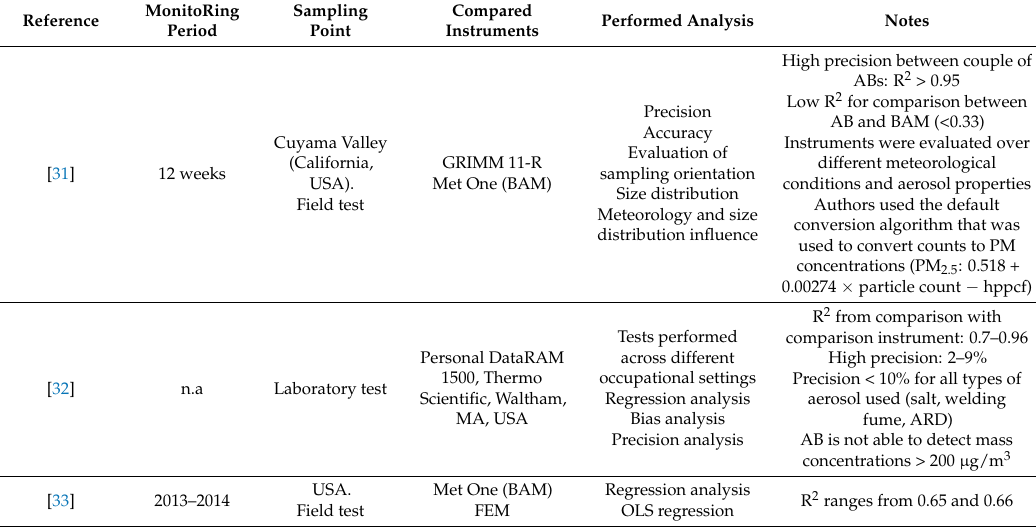
Table 1. Principal outcomes from other studies that evaluated AirBeam (AB). n.a.: not